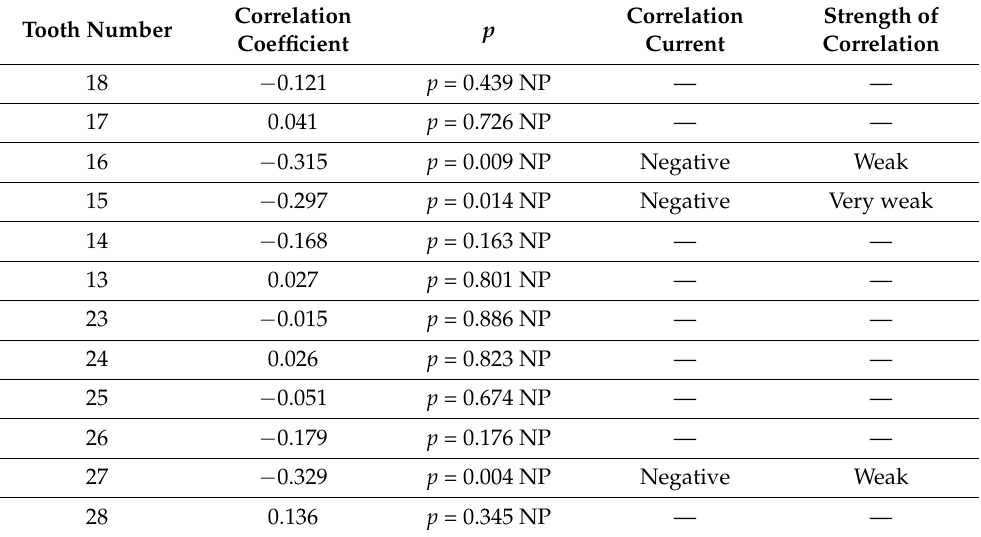
Table 4. Comparison analysis of mucosal thickening according to anatomic relation between teeth and maxillary sinus.